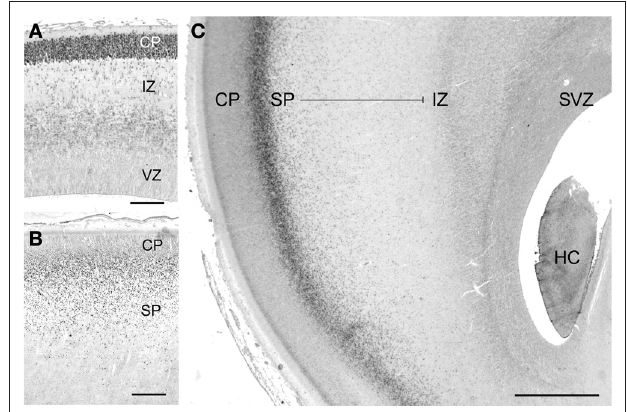
FIGURE 1 | Tbr1 marks glutamatergic neurons in the human subplate (SP). (A) At 10 gestational weeks (GW), highest Tbr1 staining is in the early cortical plate (CP). (B) At 16 GW, Tbr1 + cells are concentrated along the CP/SP border and distributed all over the SP. (C) At 25 GW, the SP, here in the temporal lobe, has increased in width and is fi lled with Tbr1 + neurons extending from the intermediate zone (IZ) to the deep CP border. The growth of the SP despite the expansion of the cortical wall indicates the continuous addition of new Tbr1 + neurons. HC, hippocampus; SVZ, subventricular zone; VZ, ventricular zone. Scale bar in (A) 100 µm, in (B) 200 µm, in (C) 1